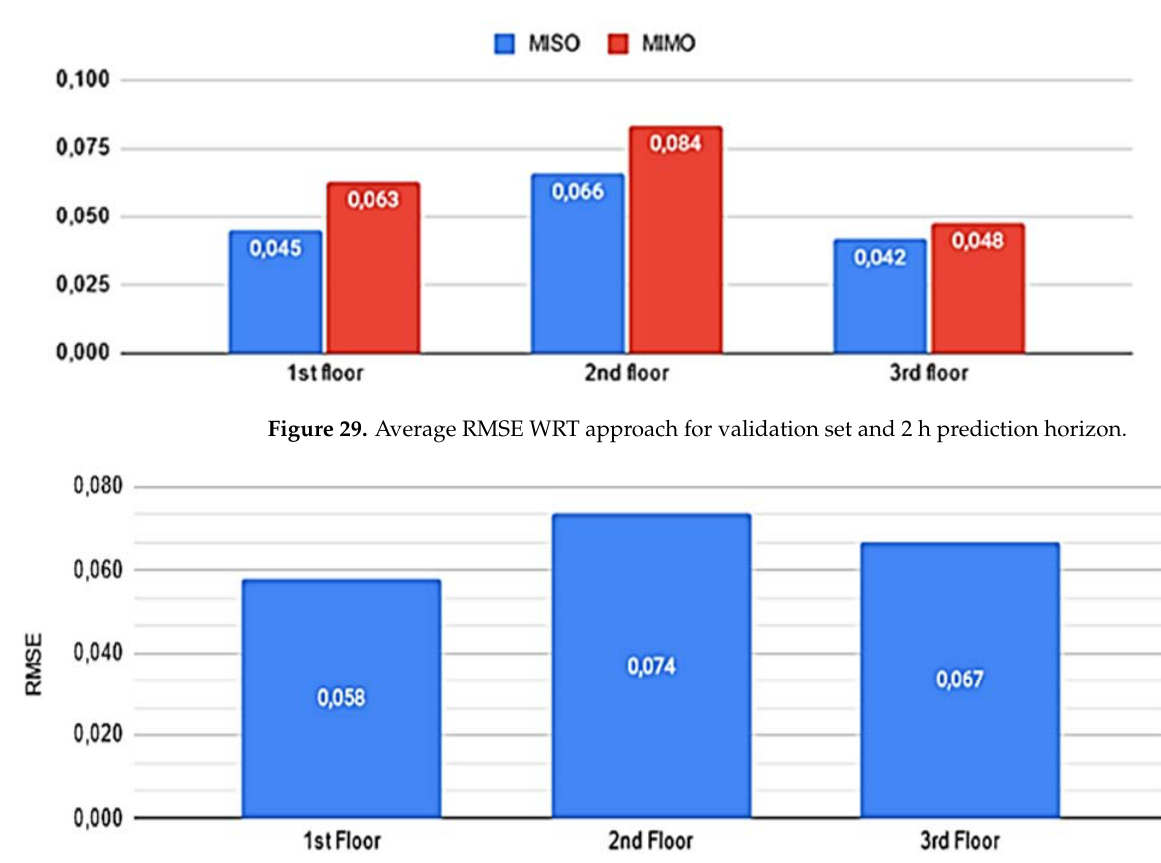
Figure 31. Model average RMSE concerning floor by prediction horizon versus floor-tailored models. On the other hand, the tests showed some results: •